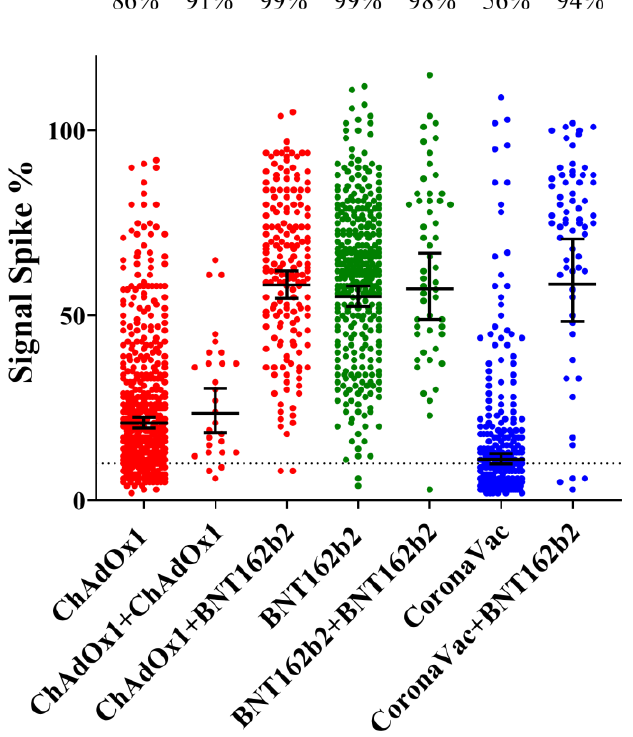
Figure 4. IgG levels reactive spike after completion of primary vaccination and after the booster dose accordingly to the vaccine type. IgG levels reactive for spike in all participants (including those negative and positive for natural infections) who completed primary vaccination (2nd dose) between 10 and 240 days are indicated accordingly to the vaccine type. The IgG levels in participants who took a 3rd booster dose is indicated with + followed by the vaccine type of the booster. Only participants who took the booster dose between 10 and 240 days were considered. The dashed line indicates the seropositive assay cutoff. The geometric mean and 95% CI are represented by the bars. Number indicates the seroconversion rates.